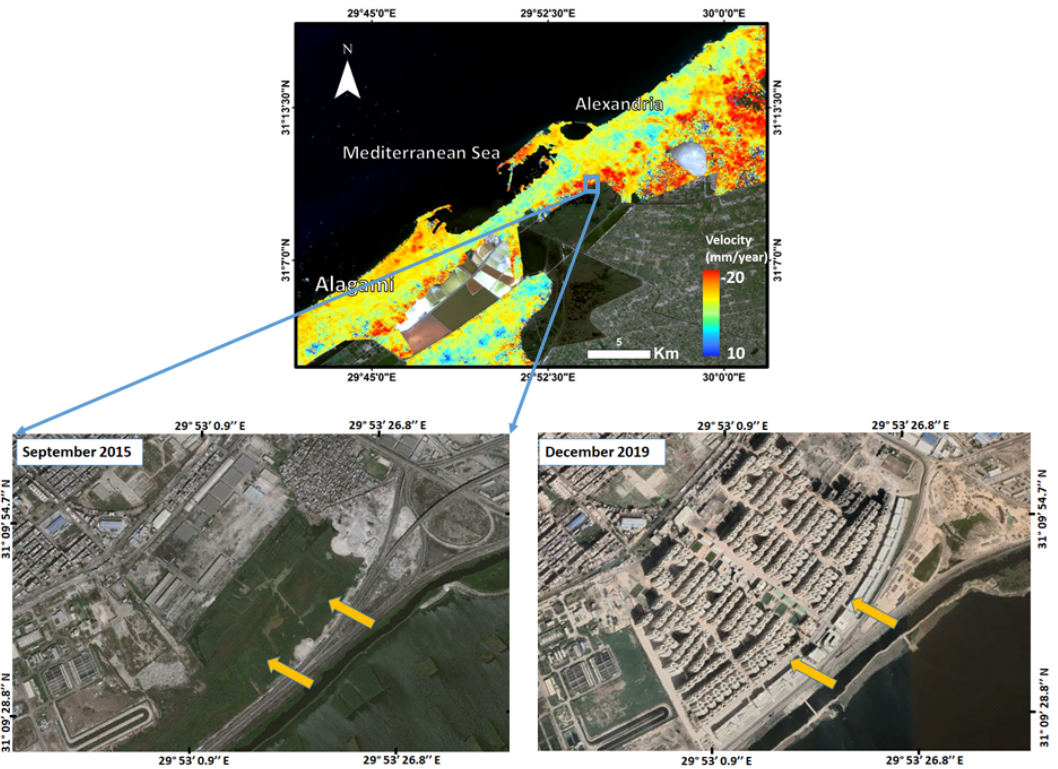
Figure 15. Shows the recent urban expansions along the border of former Mariout Lake causing land